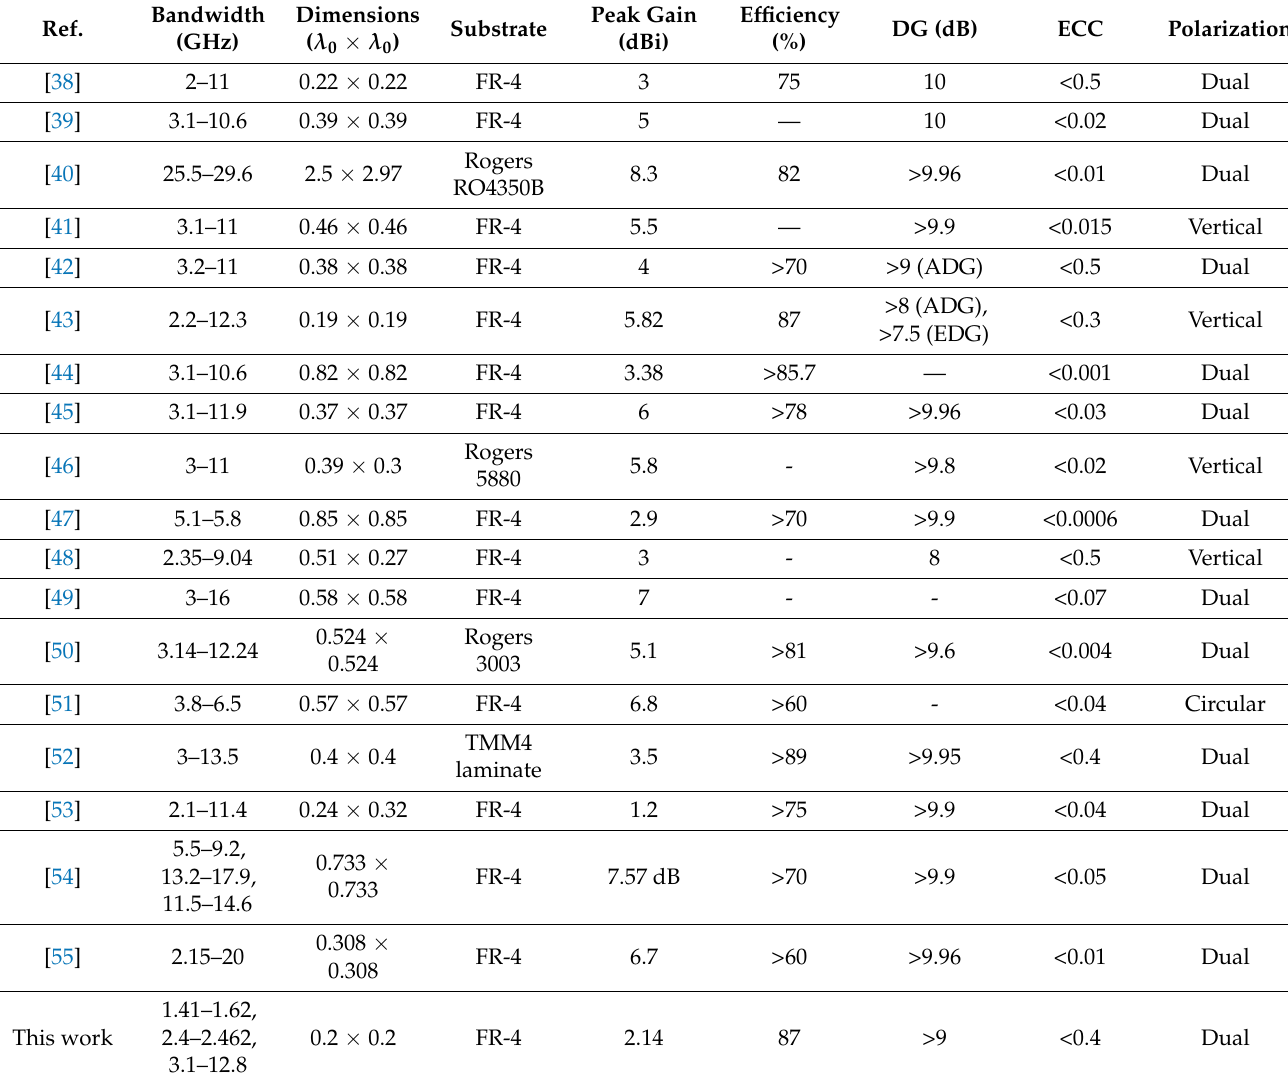
Table 3. Comparison of the proposed antenna to previously reported antenna configurations.